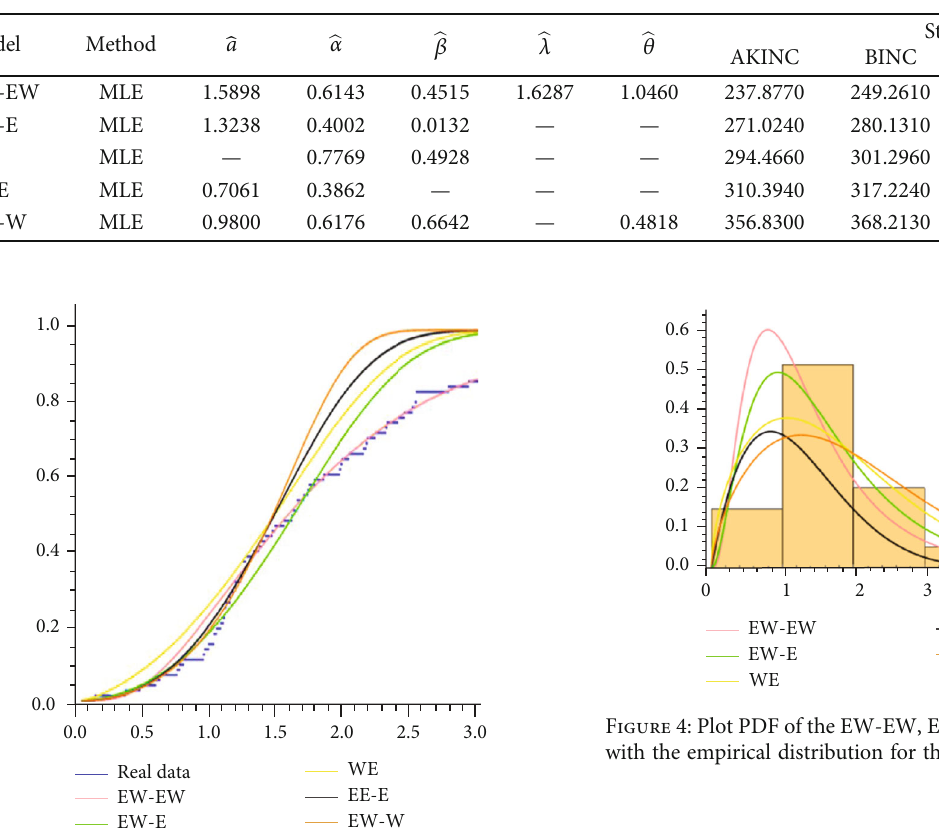
Table 5: Parameter estimates and values of AKINC, COAKINC, BINC, and HQINC for the 1 st data.